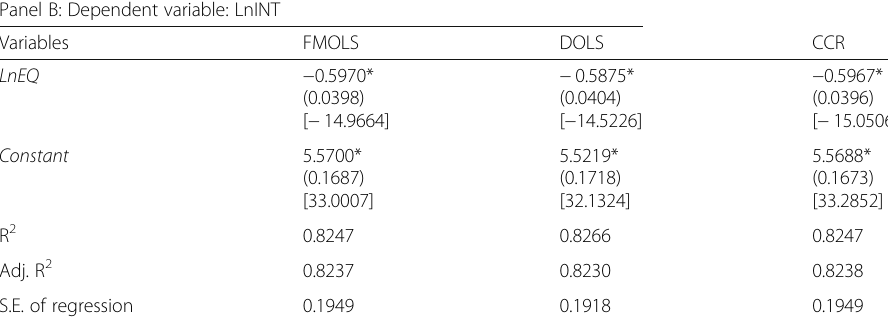
Table 4 Long-run elasticities for the dependent variable of interest rate Panel B: Dependent variable: